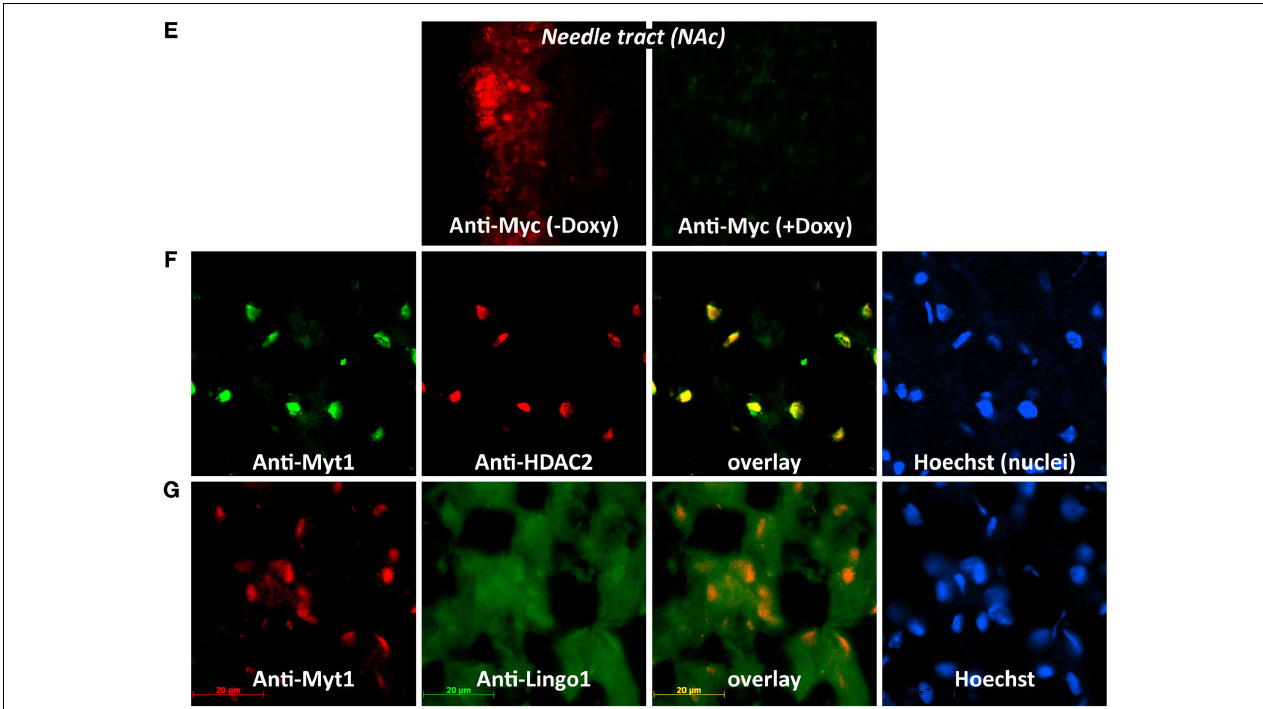
FIGURE 4 | (continued) Lentivirus-mediated expression of NZF-2b/7ZFMyt1 recruits and co-localizes with HDAC2 in neuronal nuclei in the NAc. (E) Low- magnifi cation (20 × ) of ectopic NZF-2b/7ZFMyt1 labeling with anti-Myc in the needle tract of the NAc either in the presence (red) or absence (green) of doxycycline, showing a tightly regulatable expression of ectopic, Myc -tagged NZF- 2b/7ZFMyt1. (F) Triple immunostaining with anti-Myt1 (green) and anti-HDAC2